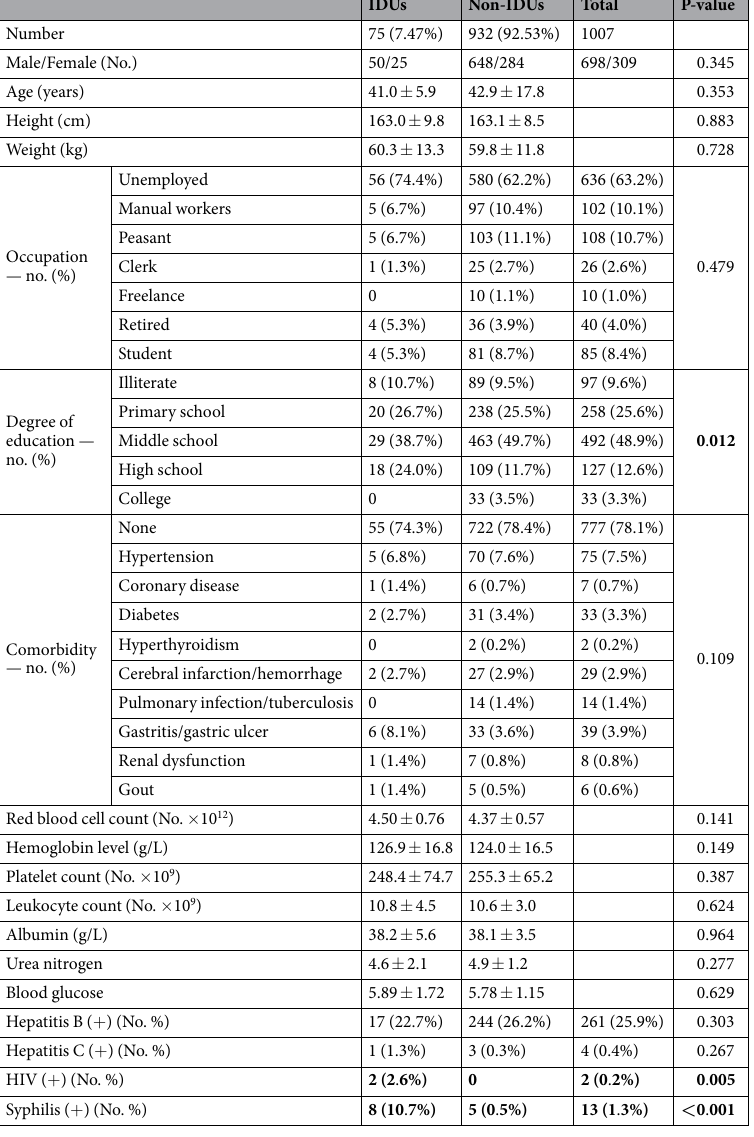
Table 1. Characteristics of